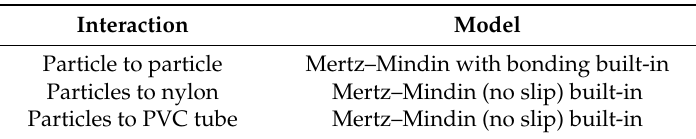
Table 3. Physical interaction